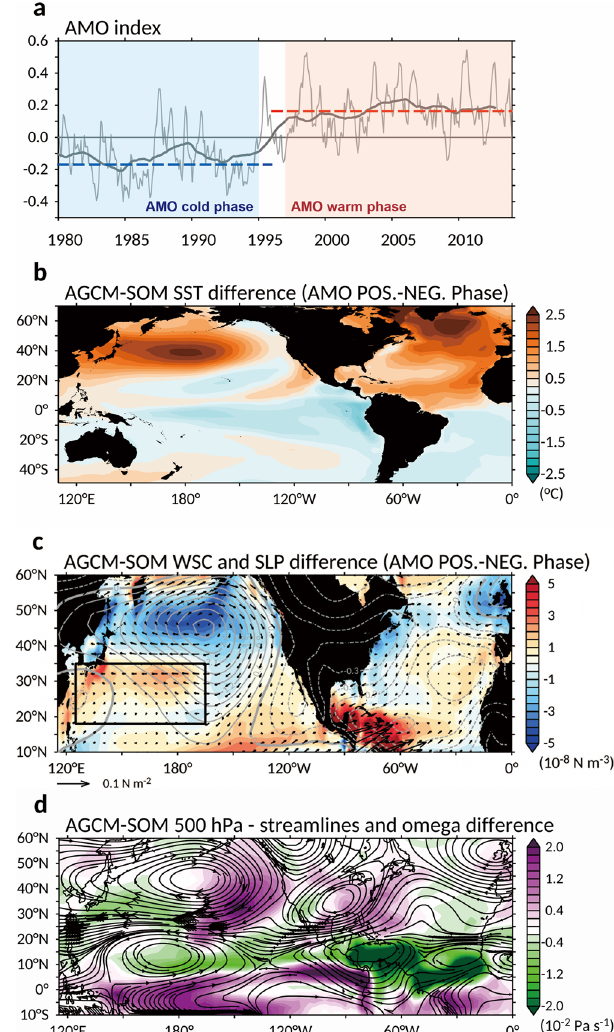
Figure 4. The AMO-related sea surface temperature and wind field. ( a) Monthly time series of AMO index (in units of °C, thin line). The bold line shows the AMO index with 61-month running mean. The AMO positive (negative) periods are marked by the red (blue) shading. Red (blue) dashed lines indicate mean of the AMO positive (negative) periods. The AMO-related ( b) , sea surface Temperature (SST), ( c) , sea level pressure (contour), wind stress (vector), wind stress curl (WSC), and ( d) , 500 hPa streamlines and vertical velocities from the AGCM-SOM experiment, calculated as differences between the AMO positive and negative runs of the model. The solid/dash contours denote positive/negative anomaly. Note that in ( b – d ), the North Atlantic SSTs were prescribed based on the regressions onto the AMO index. The black box indicates the region of the subtropical gyre (125°E–165°W;